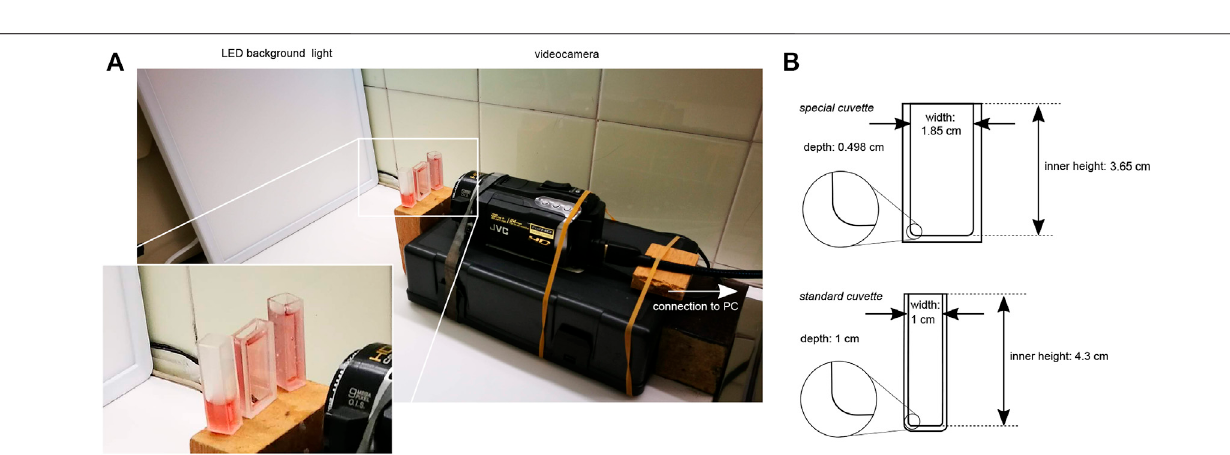
Frontiers in Chemistry |